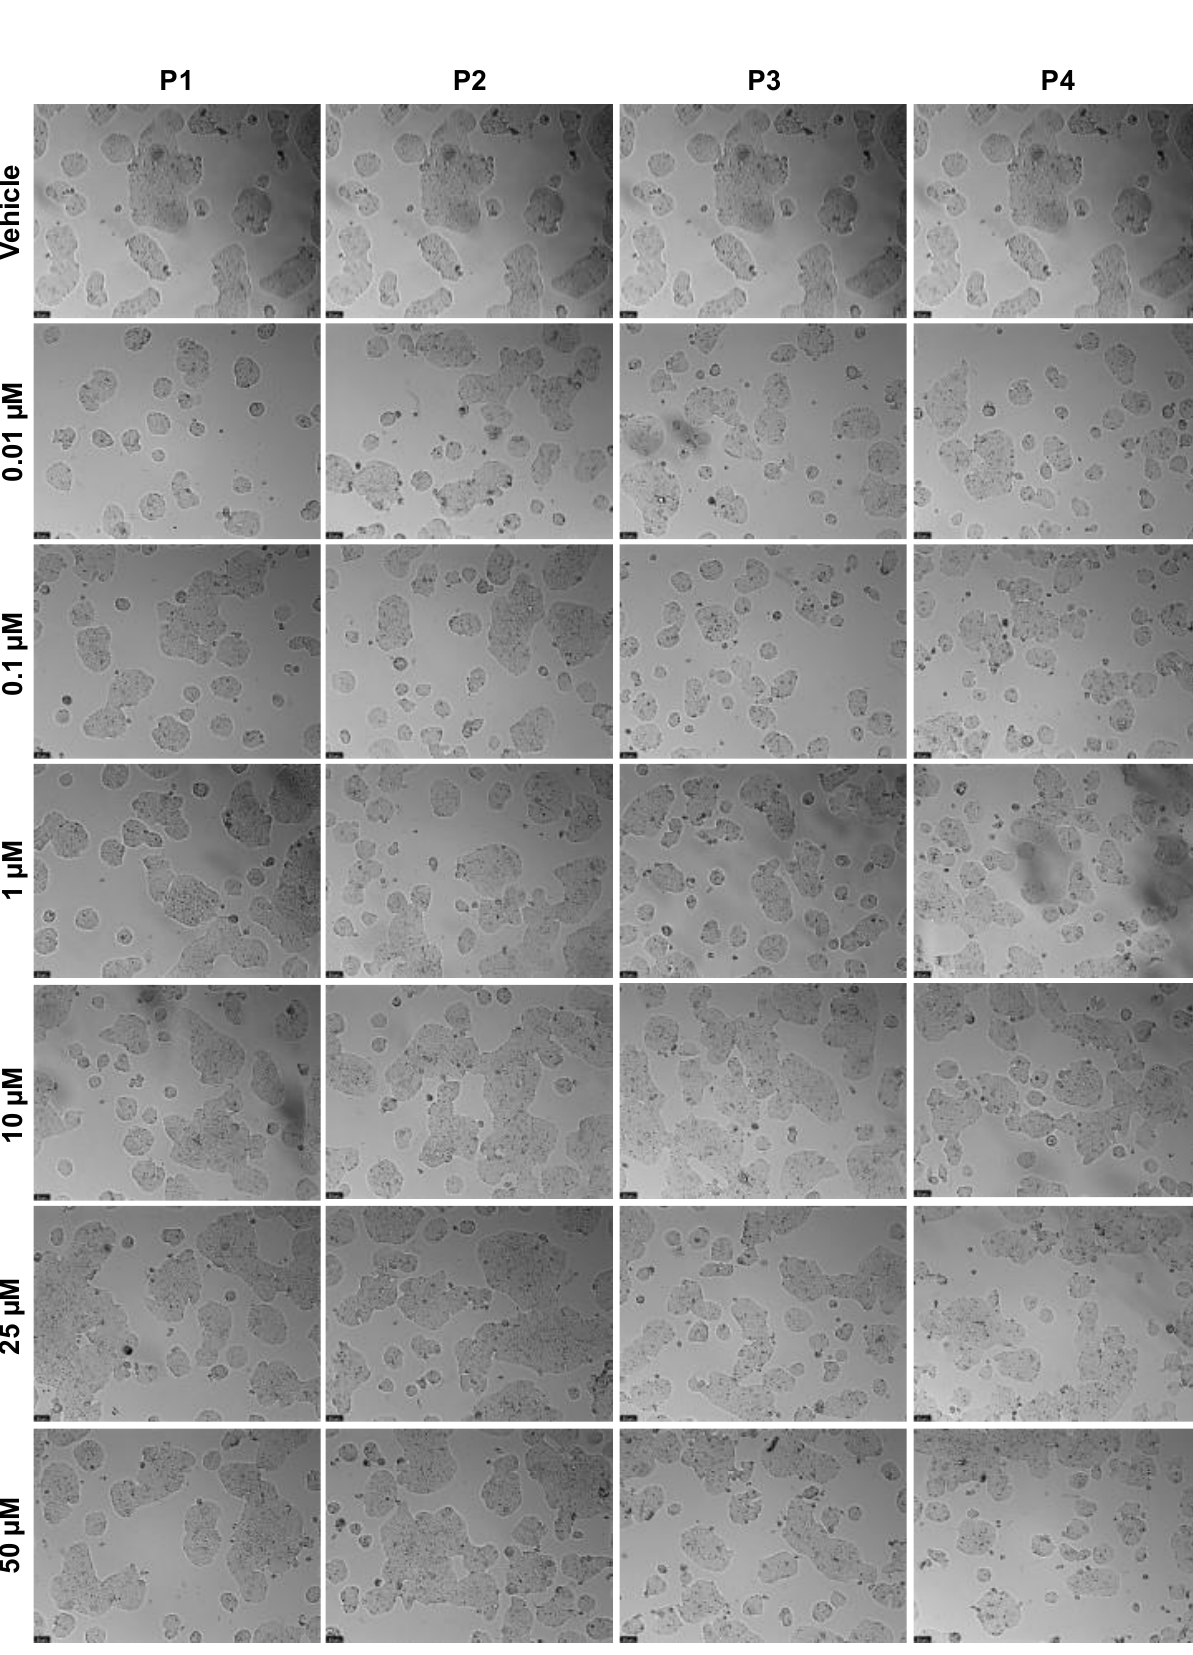
Figure 12. Morphological evaluation of HT-29 after exposure to increasing concentrations of P1 – P4 (0.01 – 50 μM) for 48 h. Control cells were treated with the vehicle (0.01% DMSO). These images are representative of three independent experiments. Scale bar is 200 μM.